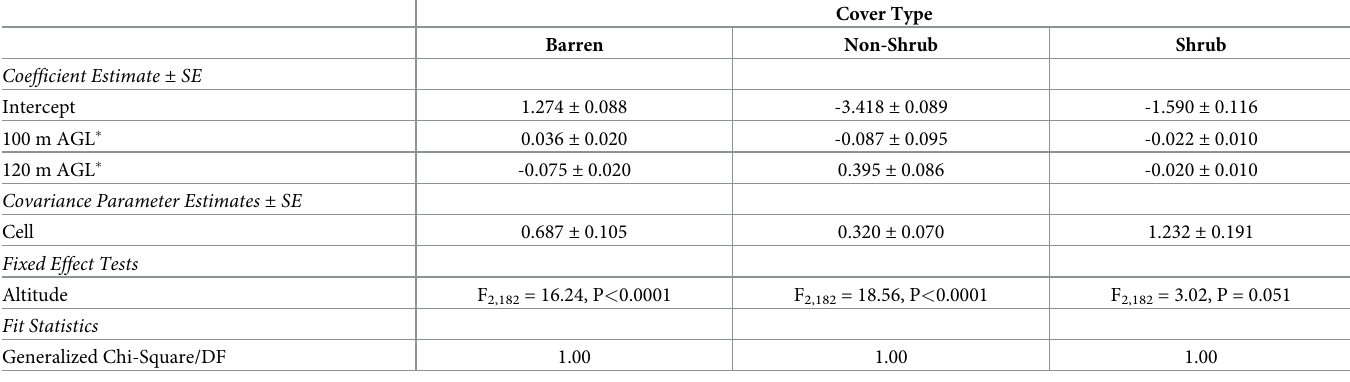
Table 2. Coefficient estimates from Beta GLMM for each cover type (barren, non-shrub, and shrub) as measured by drone pixel counts at altitudes of 75, 100 and 120m AGL. Estimates obtained from 92 observations (cells) across 5 different study plots.